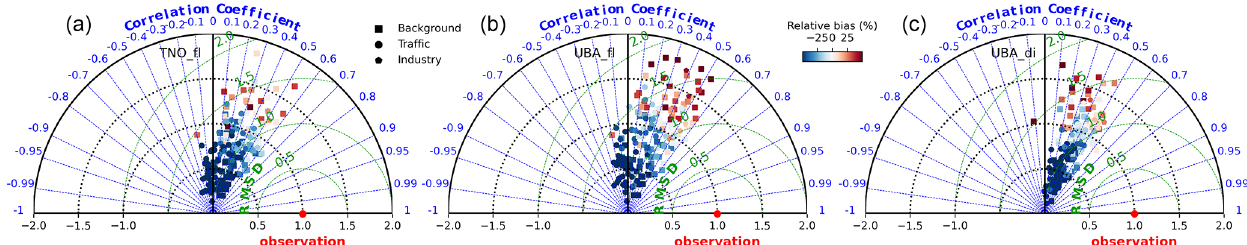
Figure 5. Taylor diagrams showing the Pearson correlation coefficients, normalized standard deviation and normalized root mean square difference corresponding to hourly resolution measured and simulated NO 2 VMRs (in CM02 domain) for background, traffic and industrial sites represented as square, circle and pentagon markers, respectively. Panels (a) , (b) and (c) correspond to the TNO fl , UBA fl and UBA di set-ups,